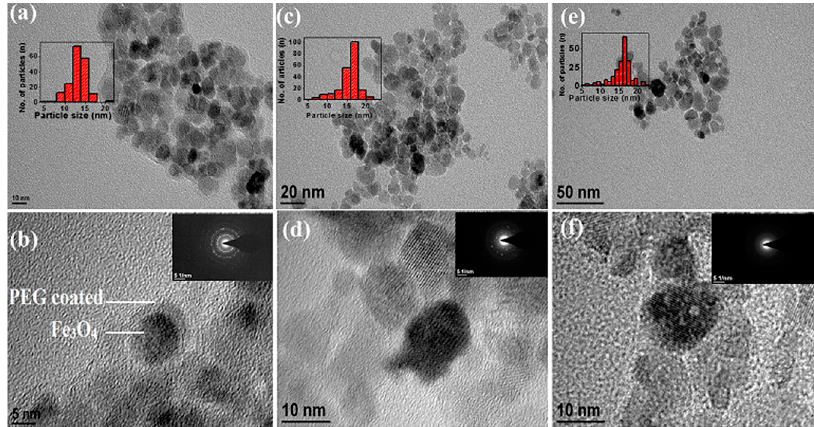
Figure 2. ( a ) TEM image and ( b ) high resolution transmission electron microscopy (HRTEM) image of sample S1; ( c ) TEM image and ( d ) HRTEM image of sample S2; ( e ) TEM image and ( f ) HRTEM image of sample S3. The insets show the size histograms and the selected area electron diffraction (SAED) patterns confirming the polycrystalline nature of the samples.